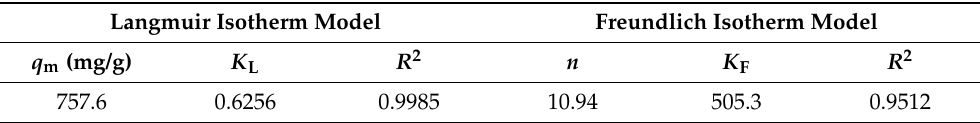
Table 3. Estimated parameters of Langmuir and Freundlich linear fittings for the adsorption of AO7 molecule onto mesoporous CeO 2 synthesized hydrothermally at 140 ◦ C for 24 h with 10 mL H 2 O 2 at room